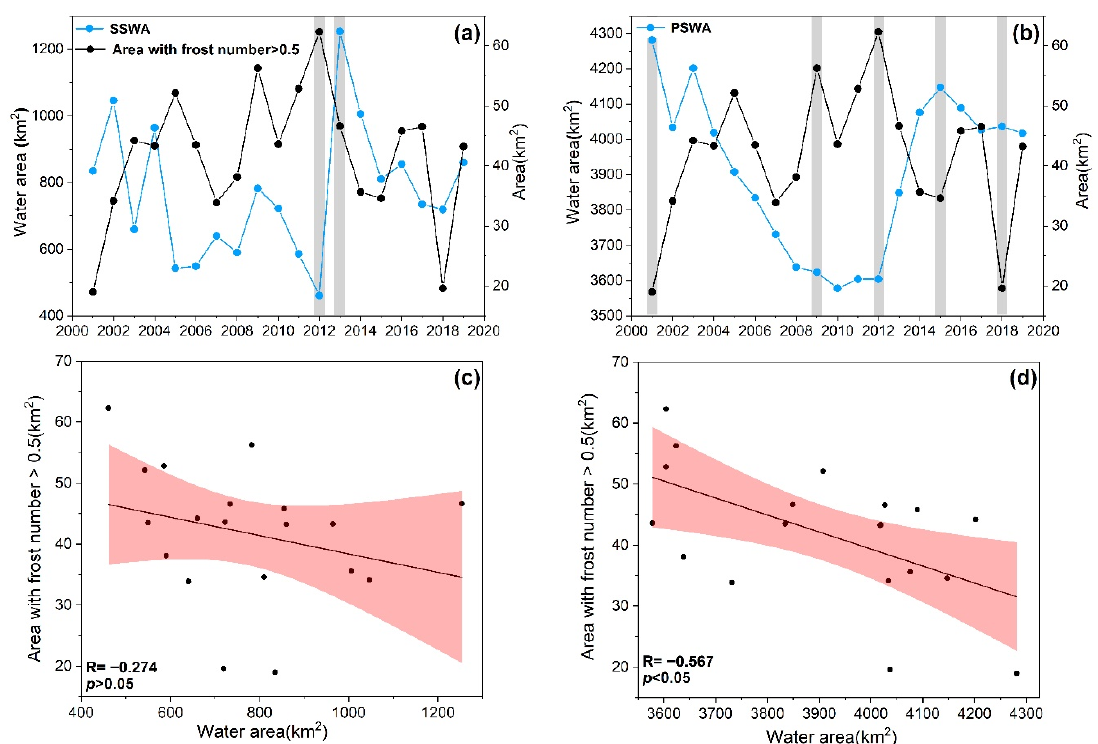
Figure 11. The interannual variation trend of SWA and the area with frost number >0.5 of the Argun River Basin and their correlation: ( a , b ) are the temporal changes of SSWA, PSWA, and the area of frost number >0.5, ( c ) is the correlation between SSWA and the area with frost number >0.5, and ( d ) is the correlation between PSWA and the area with frost number